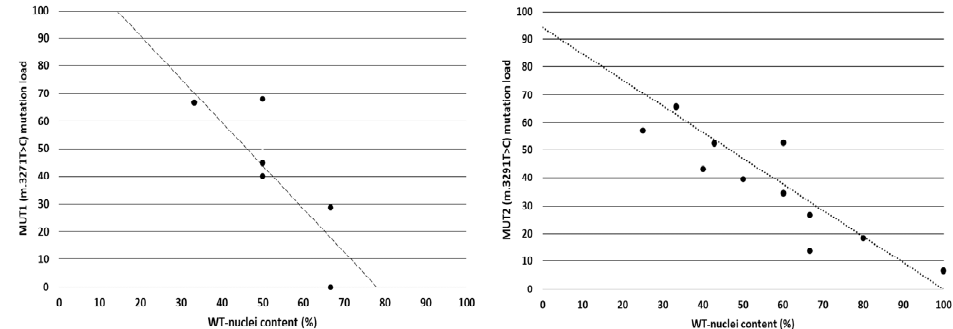
Figure 5. MUT1 (m.3271T>C) ( n = 6) and MUT2 (m.3291T>C) ( n = 11) mutation load (Y-axis) in individual fused myotubes relative to the fusion ratio with control MABs (X-axis). The black dotted line indicated the expected mutation load to fusion ratio based on the initial mtDNA mutation load in the parental MABs.